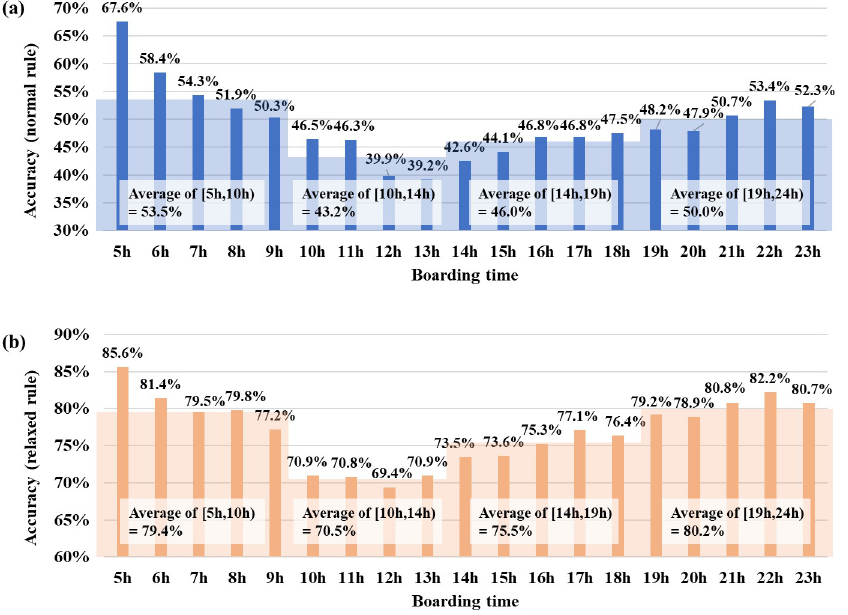
Fig 11. Estimation accuracies by the time range of the day (a. normal rule, b. relaxed rule).